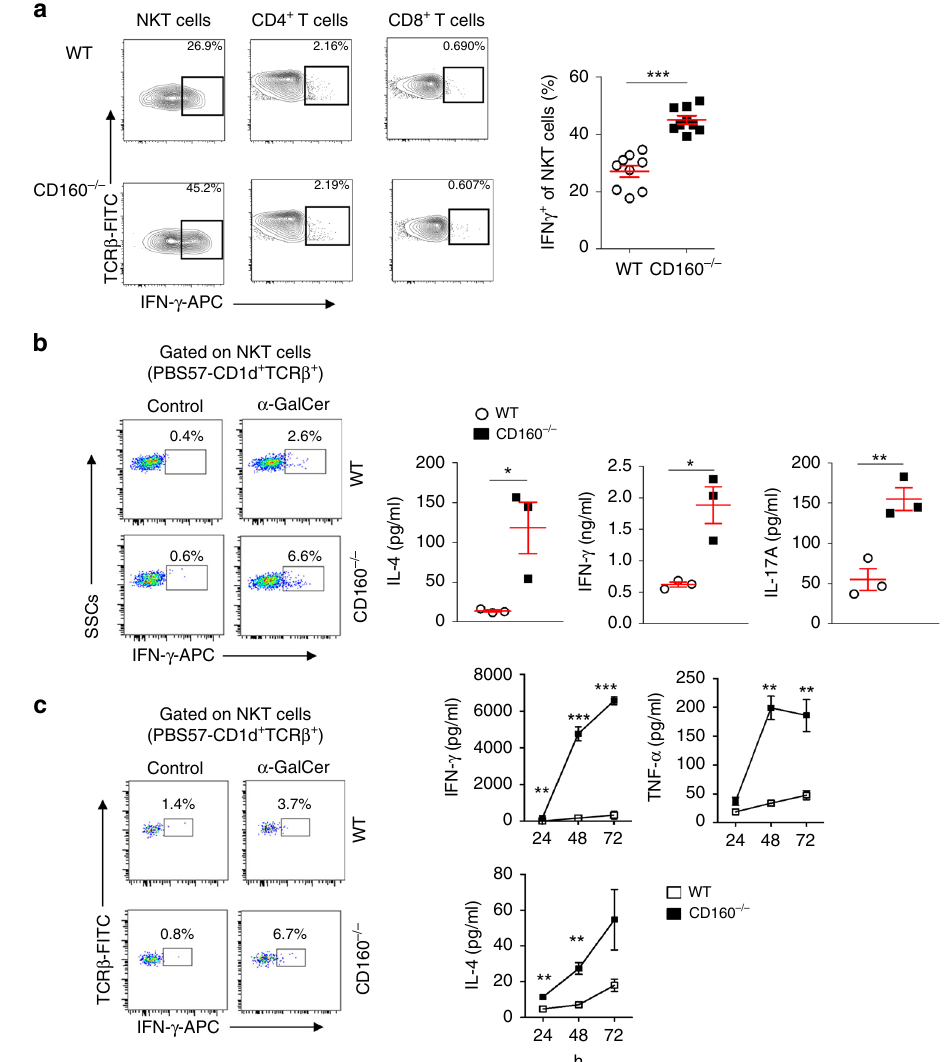
Fig. 4 Expression of IFN- γ and surface co-receptors on NKT cells. a Representative fl ow cytometric analyses of intracellular IFN- γ expression in liver NKT, CD4 + , and CD8 + T cells isolated from WT and CD160 − / − mice injected with 2 μ g of α -GalCer for 4 h. Liver MNCs were treated with Brefeldin A to block cytokine release for the last 6 h in culture for intracellular IFN- γ staining. The graphs represent the frequency of IFN- γ -expressing NKT cells ( n = 9 per each group). b Liver MNCs (2 × 10 5 ) from littermates of WT and CD160 − / − mice were cultured with α -GalCer (100 ng/ml) for 24 h. Cells were treated with Brefeldin A to block cytokine release for the last 6 h in culture for intracellular IFN- γ staining. Levels of IL-4, IFN- γ , and IL-17A in the culture supernatants at 24 h were measured by CBA. Results are representative of three independent experiments ( n = 3 per group). c Splenocytes (3 × 10 5 cells) from littermates of WT and CD160 − / − mice were cultured with α -GalCer (100 ng/ml) and IL-2 (50 U / ml) for 24 h. Cells were fi xed and permeabilized prior to intracellular staining. Levels of IL-4, IL-6, IFN- γ , and TNF- α in the culture supernatants for 24, 48, and 72 h were measured by CBA ( n = 3 per group). All data are presented as mean ± S.E.M. * P < 0.05, ** P < 0.01, *** P < 0.001 with an unpaired two-tailed T